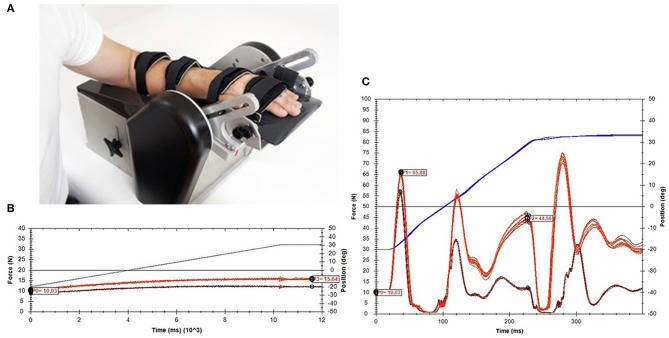
NeuroFlexor method. (A) Measurement set-up. (B) An example of data obtained during slow movements (5°/s). (C) An example of data obtained during fast movements (236°/s).